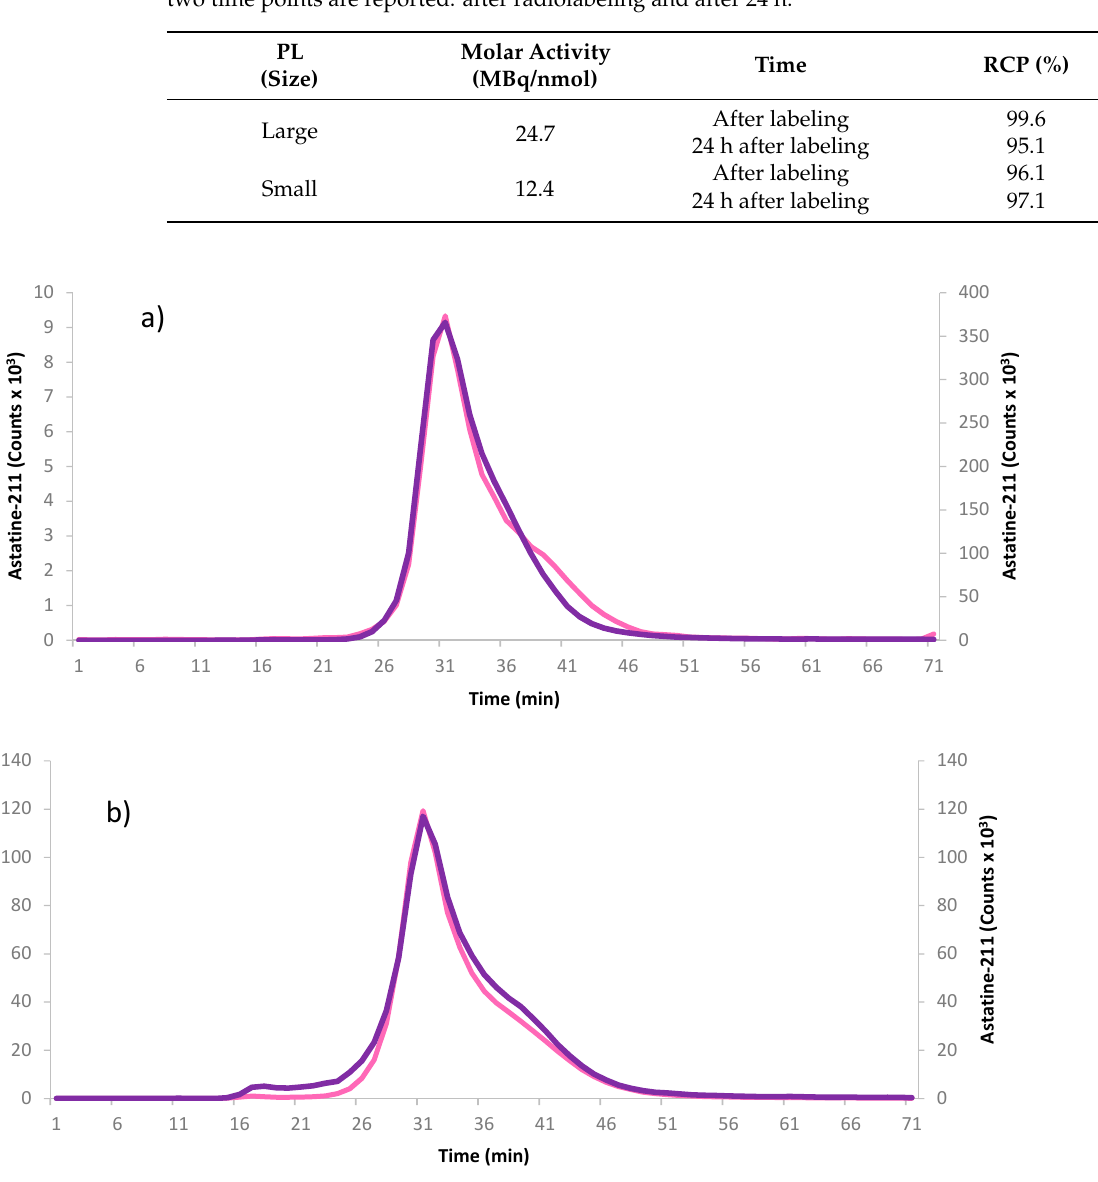
Table 3. Stability study of radiochemical purity (RCP) of two poly-L-lysine (PL) sizes (large PL: 22.5 kDa and small PL: 10 kDa) over 24 h after high-activity labeling. RCP values of astatinated PL at two time points are reported: after radiolabeling and after 24 h.